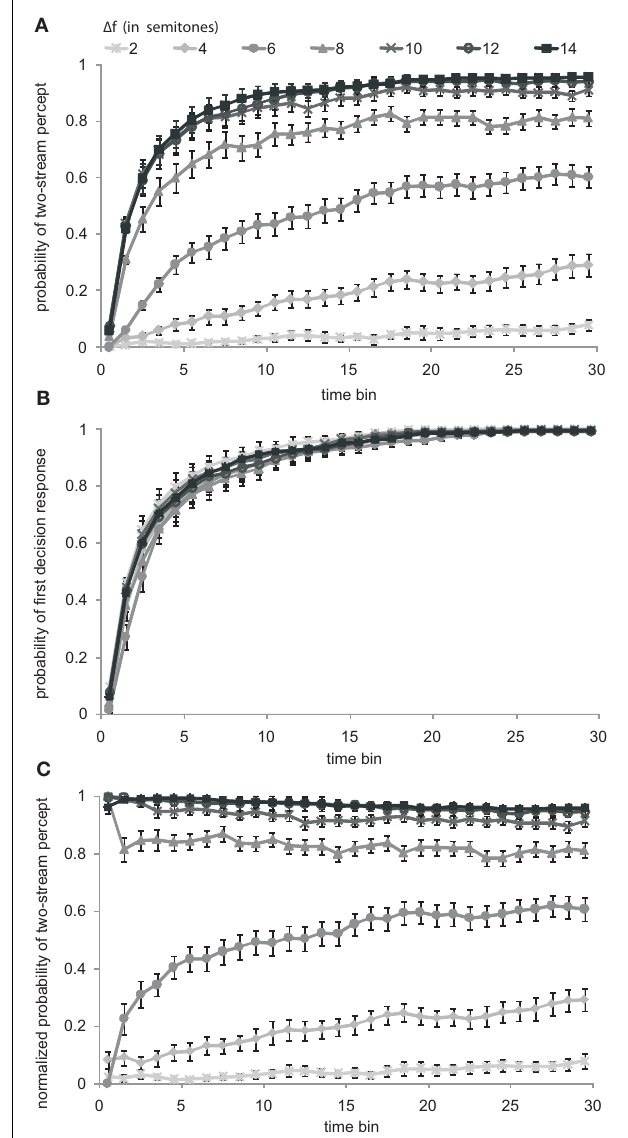
FIGURE 3 | Build-up of stream segregation: conventional versus normalized analysis. (A) Probabilities of the two-stream percept are shown as functions of time (bin size 1s) from sequence onset, for all tested ∆ f conditions (gray scaled).The probability values were plotted at the center of the 1-s bins. Symbols and error bars represent mean and SEM. All functions show an asymptotic increase that has been interpreted as reflecting a build-up of stream segregation.The apparent build-up is strongest for the large semitone intervals. (B) Probabilities of the occurrence of the first response, representing the initial perceptual decision, are shown as functions of time from sequence onset. (C) Probabilities of the two-stream percept as in (A) but normalized by the probability that a first response has been made at all, as shown in (B) . Conventions in (A) also apply to (B,C)